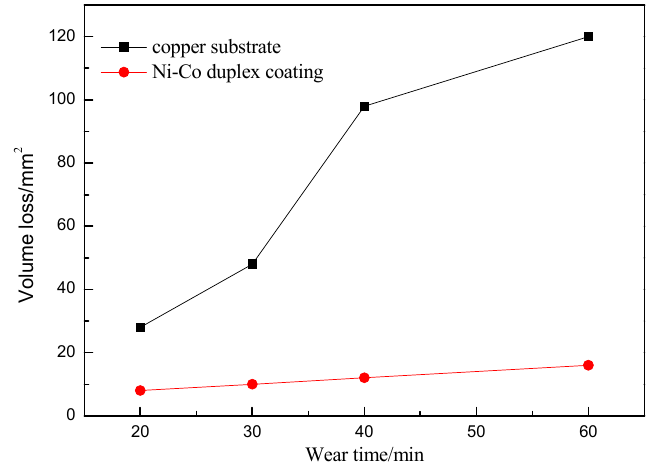
Figure 10. Wear resistance of the Ni–Co duplex coating.